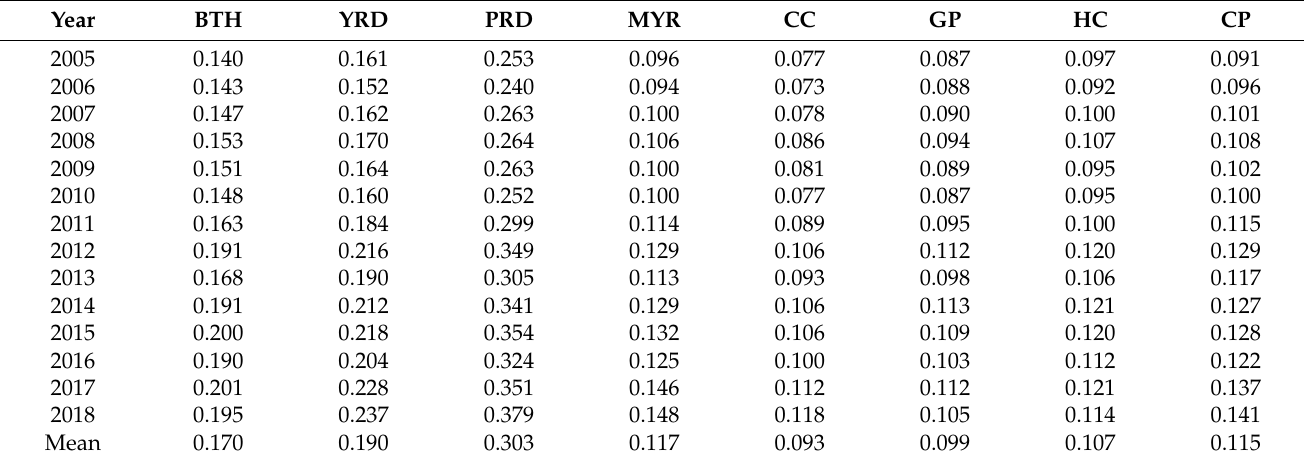
Table 2. The level of urban resilience in the eight urban